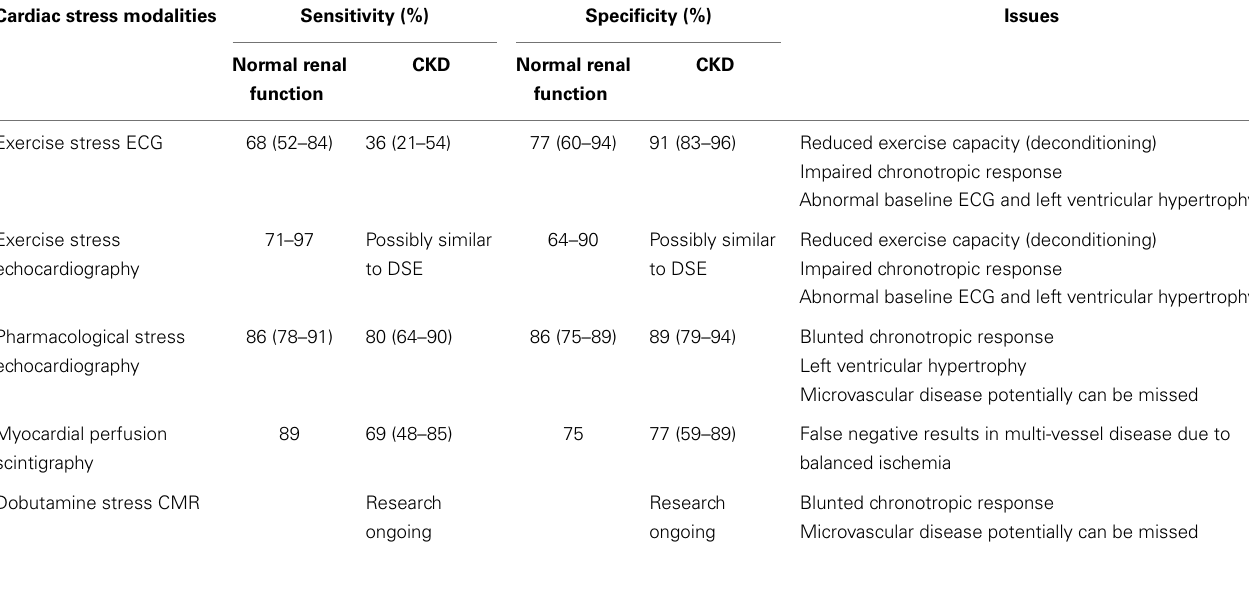
Table 2 | Cardiac stress investigations in the normal renal function versus advanced chronic kidney disease (CKD) patients